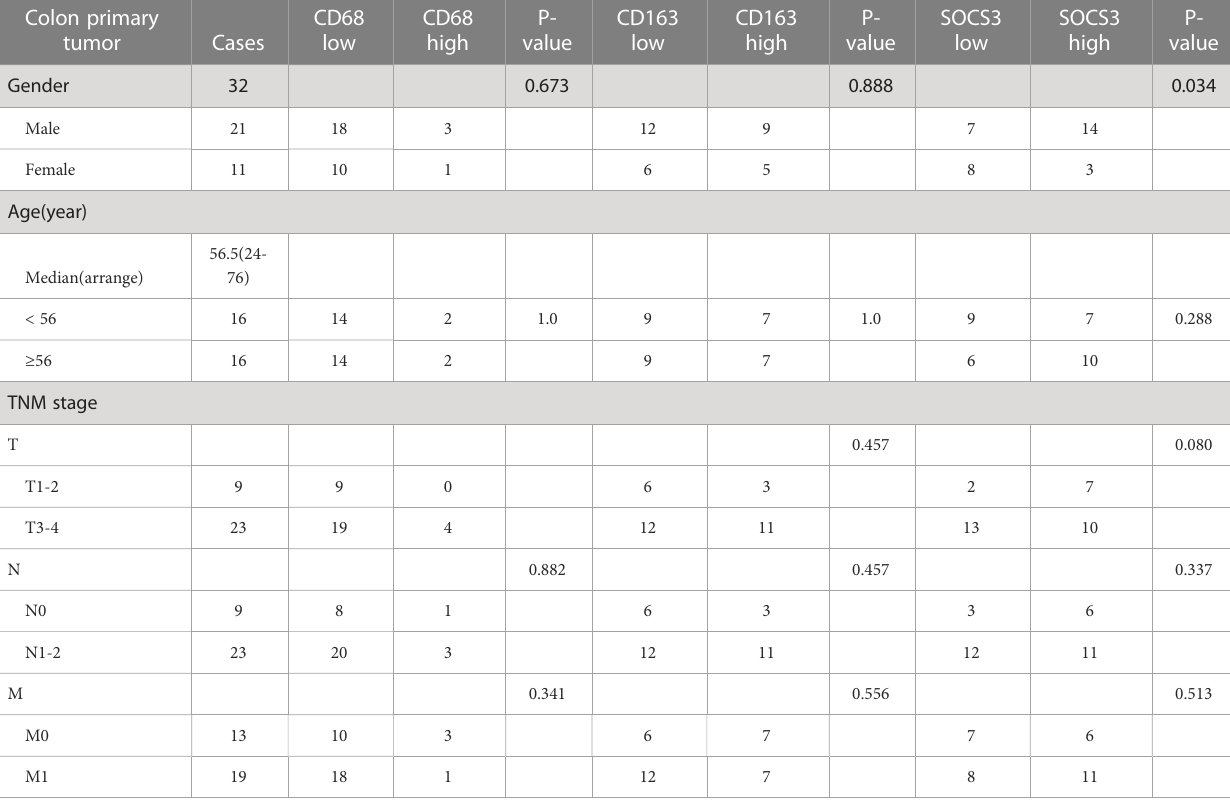
TABLE 2 Correlation between clinical characteristics and status of CD68, CD163, and SOCS3 in lung metastasis.